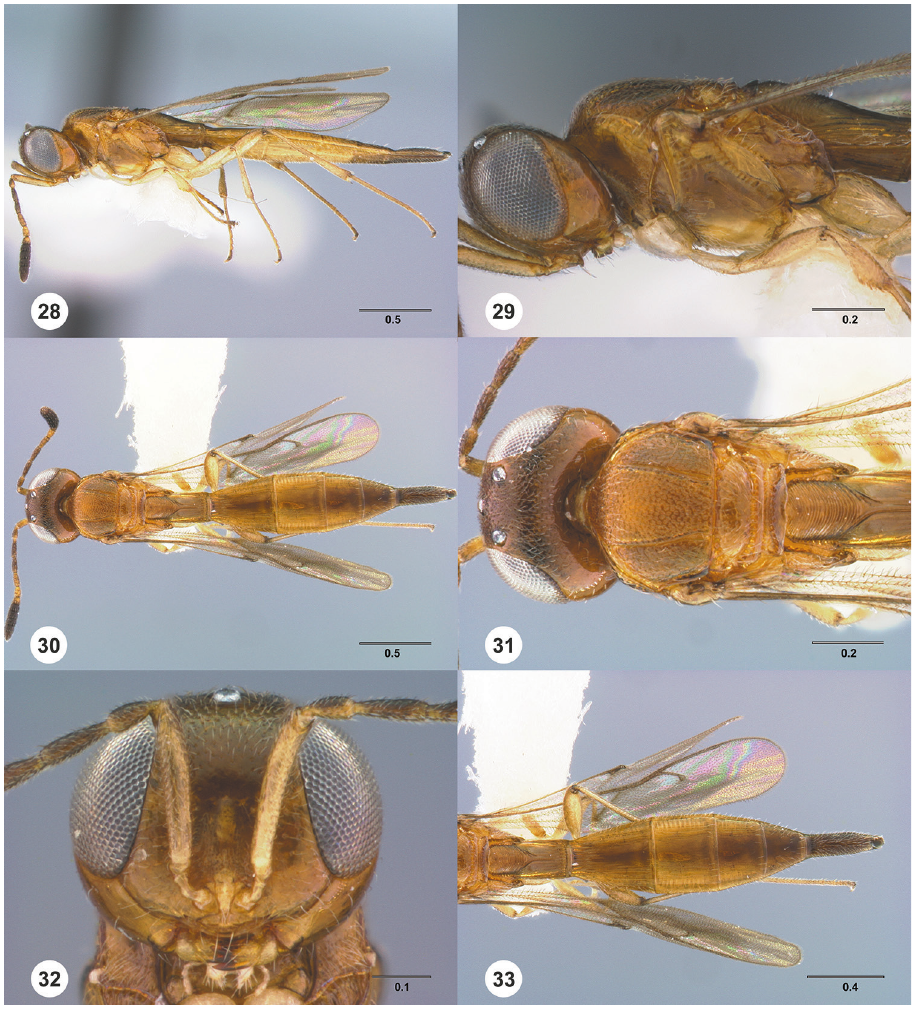
Figures 28–33. Calliscelio alcoa sp. n., female, holotype (OSUC 458212). 28 Lateral habitus 29 Head and mesosoma, lateral view 30 Dorsal habitus 31 Head and mesosoma, dorsal view 32 Head, anterior view 33 Metasoma, dorsal view. Scale bars in